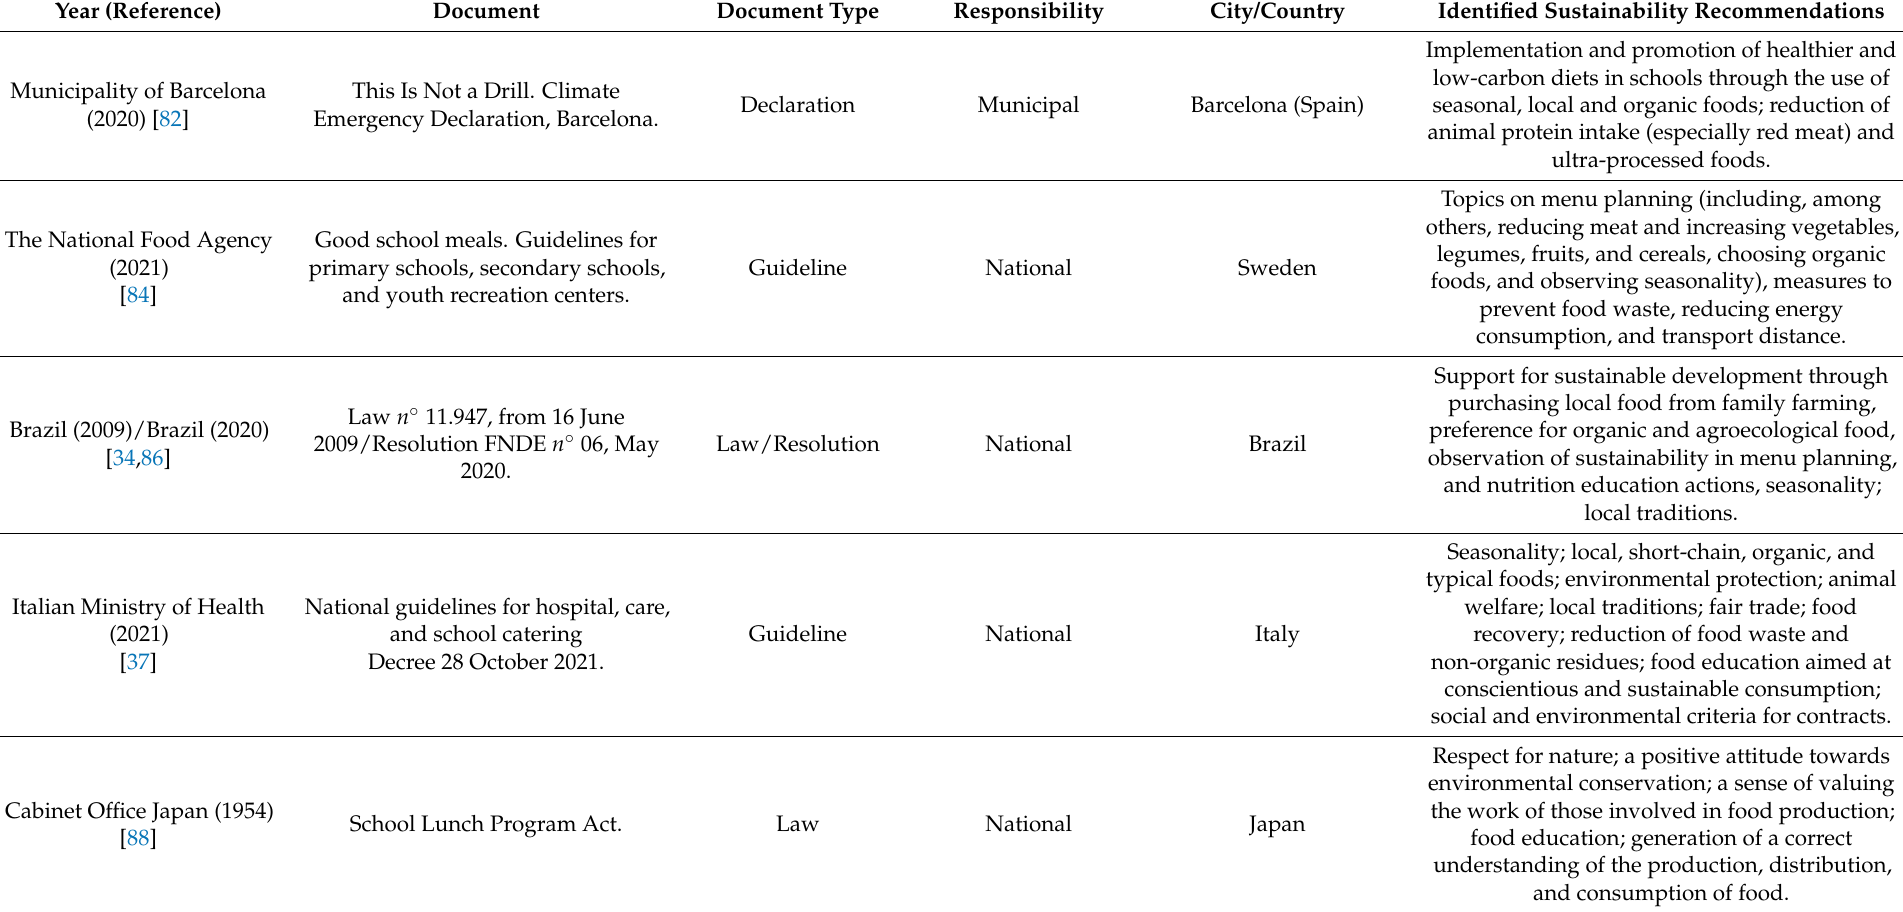
Table 2. Identified Sustainability recommendations in governmental school food policies